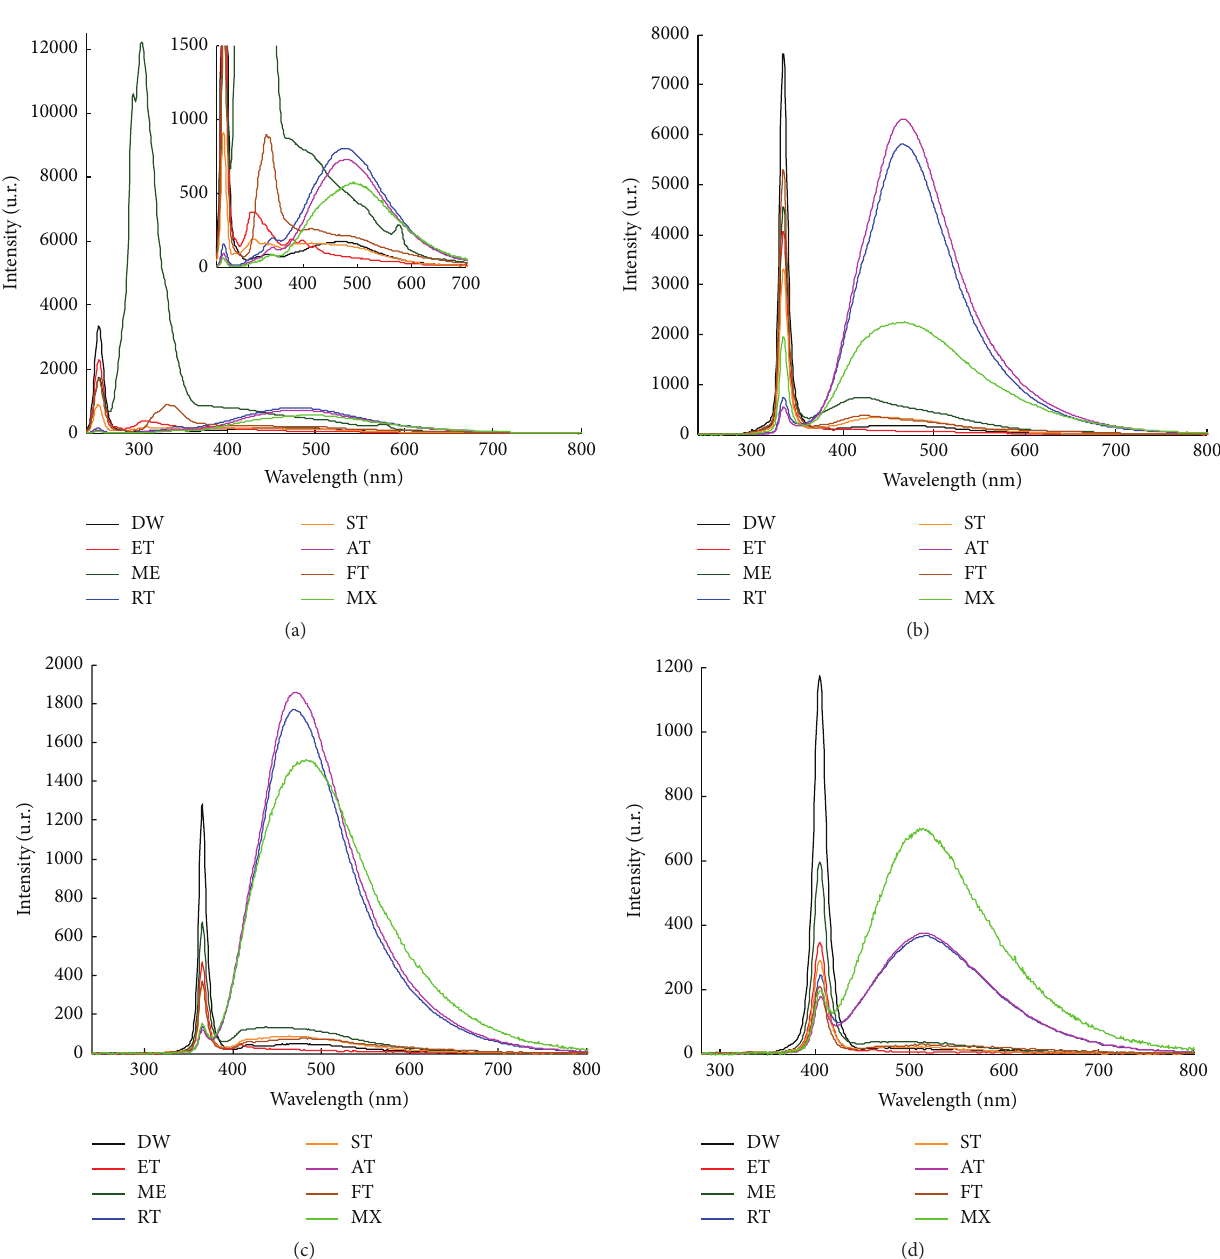
but their fluorescent intensity is considerably lower